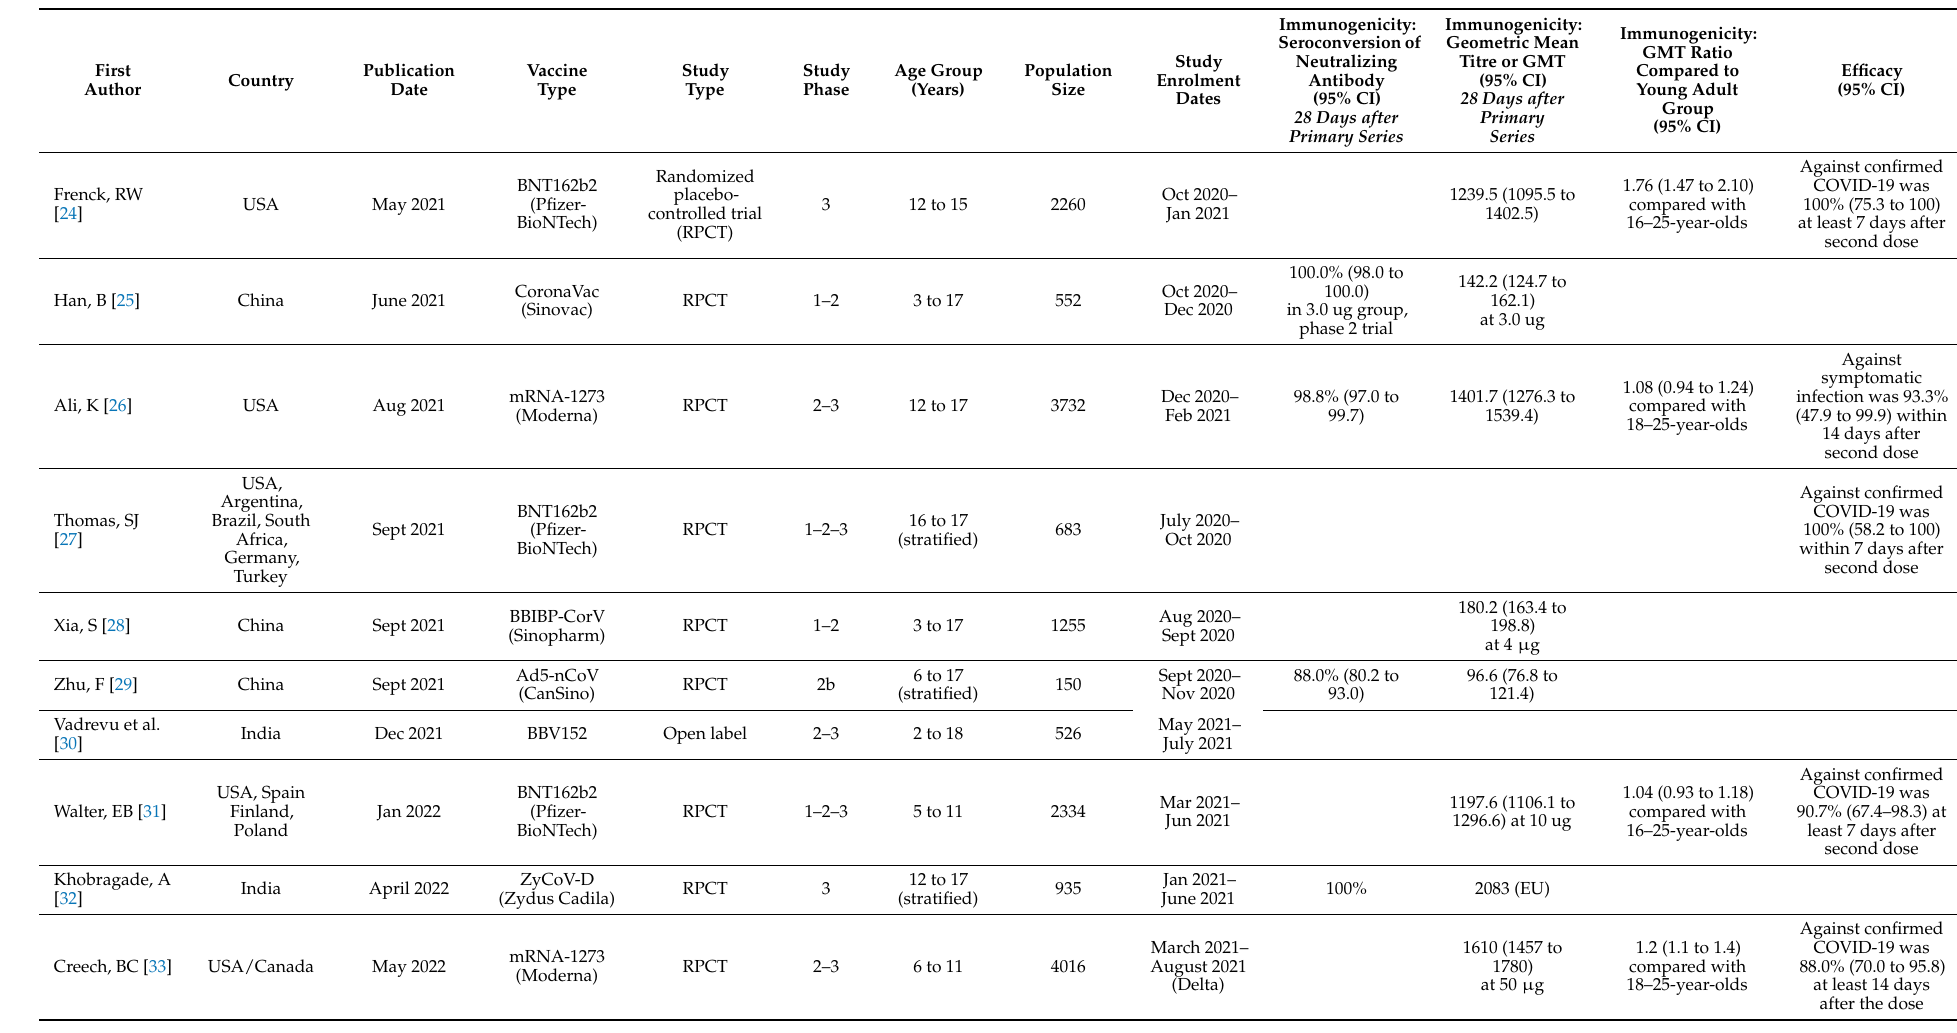
Table 1. Studies included in the safety and efficacy review of the